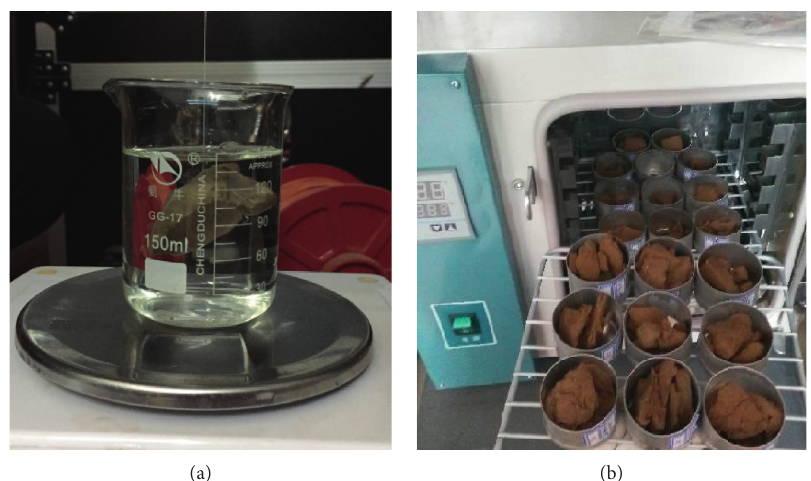
Figure 2: Schematic of physical parameters test system. (a) Wax sealing experiment. (b) Drying experiment.